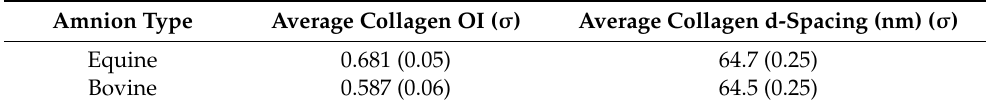
Table 3. Collagen fibril structural parameters from SAXS.